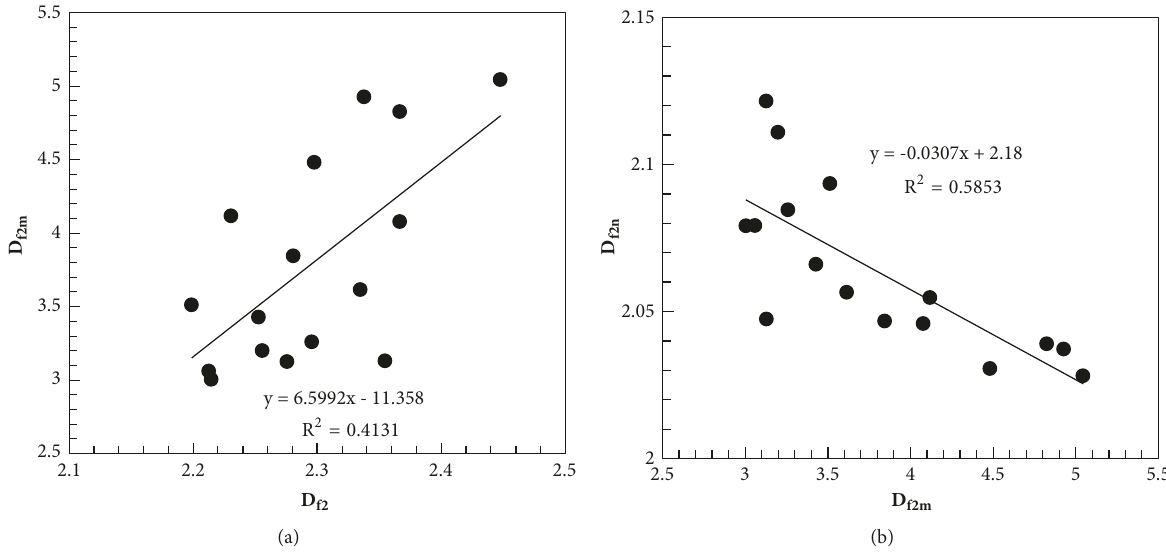
Figure 5: The relationship between fractal dimensions of entire pores 𝐷 𝑓2 , microscale pores 𝐷 𝑓2 m , and nanoscale pores 𝐷 𝑓2 n ((a) the relationship between fractal dimensions of the entire pores 𝐷 𝑓2 and fractal dimensions of microscale pores 𝐷 𝑓2 m ; (b) the relationship between fractal dimensions of microscale pores 𝐷 𝑓2 m and fractal dimensions of nanoscale pores 𝐷 𝑓2 n